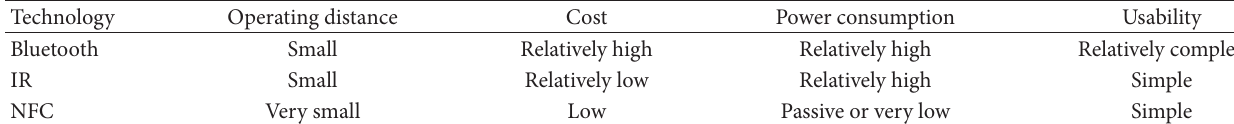
Table 1: Comparison among NFC, Bluetooth, and InfraRed (IR) technologies.